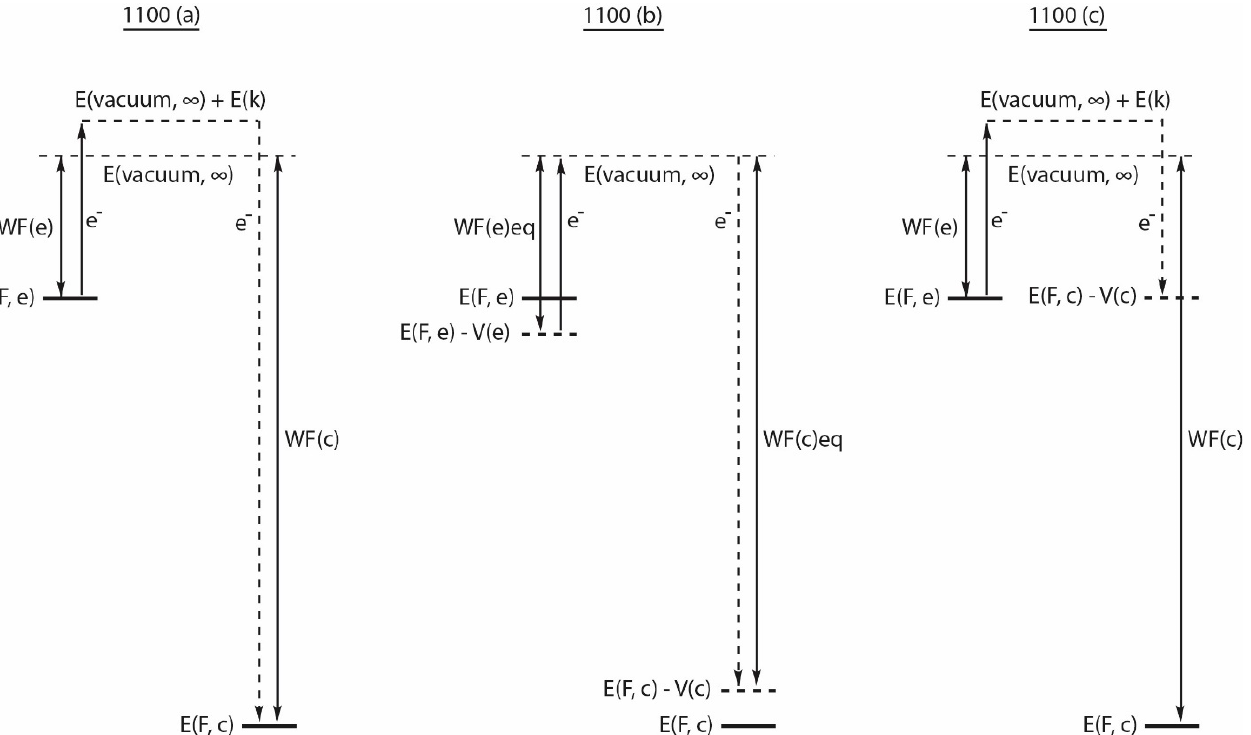
Figure 3. Presents the energy diagrams of the asymmetric electron-work-function-gated isothermal electricity power production system 1100. ( a ) the energy diagram of the system 1100 (Figure 2a) at its initial state; ( b ) the energy diagram of the system 1100 (Figure 2b) under its “open circuit” condition; and ( c ) the energy diagram of the system 1100 (Figure 2c) in equilibrium under its “open circuit” condition with its emitter grounded as “a preferred practice”.